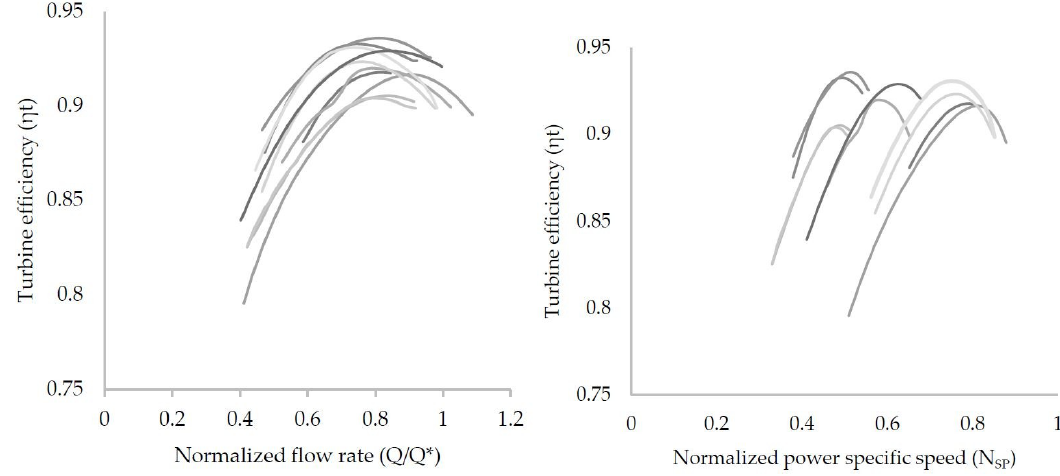
ffi ciency for a selection of the turbines in the described PSPs, function of unit 7 Figure 7. Anonymized e flow (left) and function of power specific speed